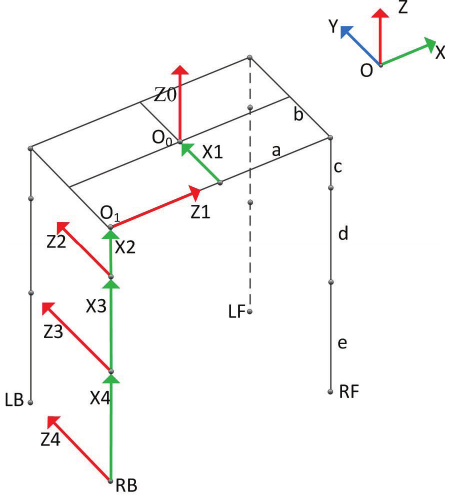
Figure 2. Kinematic model of the quadruped